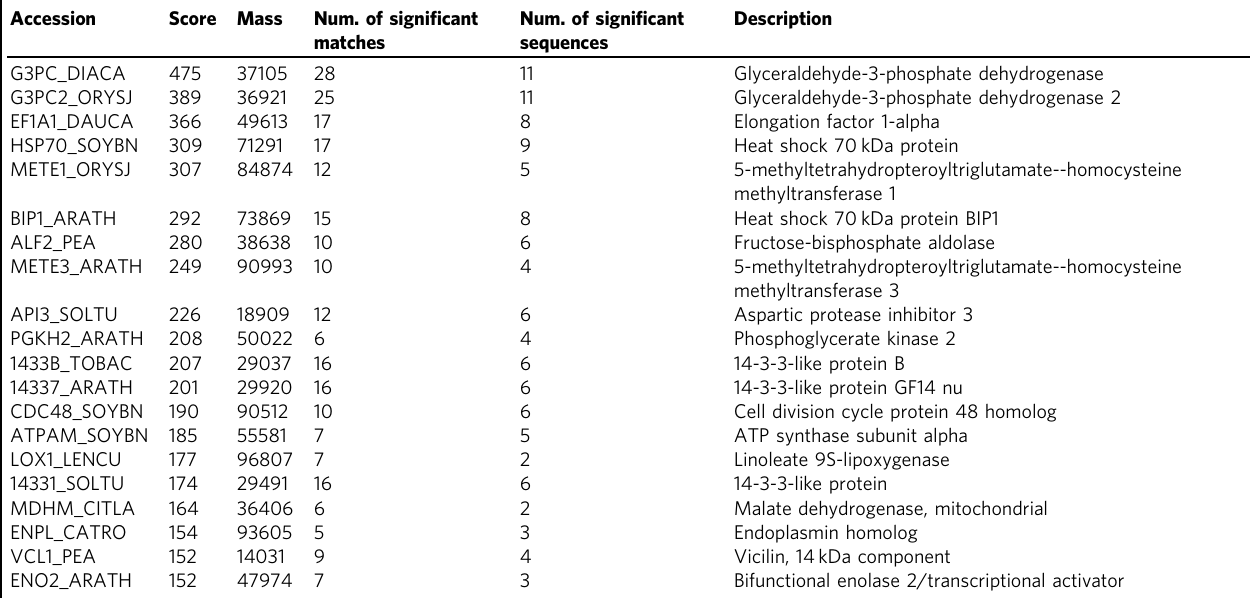
Table 1 List of the 20 vesicle proteins showing the highest score in the Mascot-based bioinformatics analysis carried out on proteomic